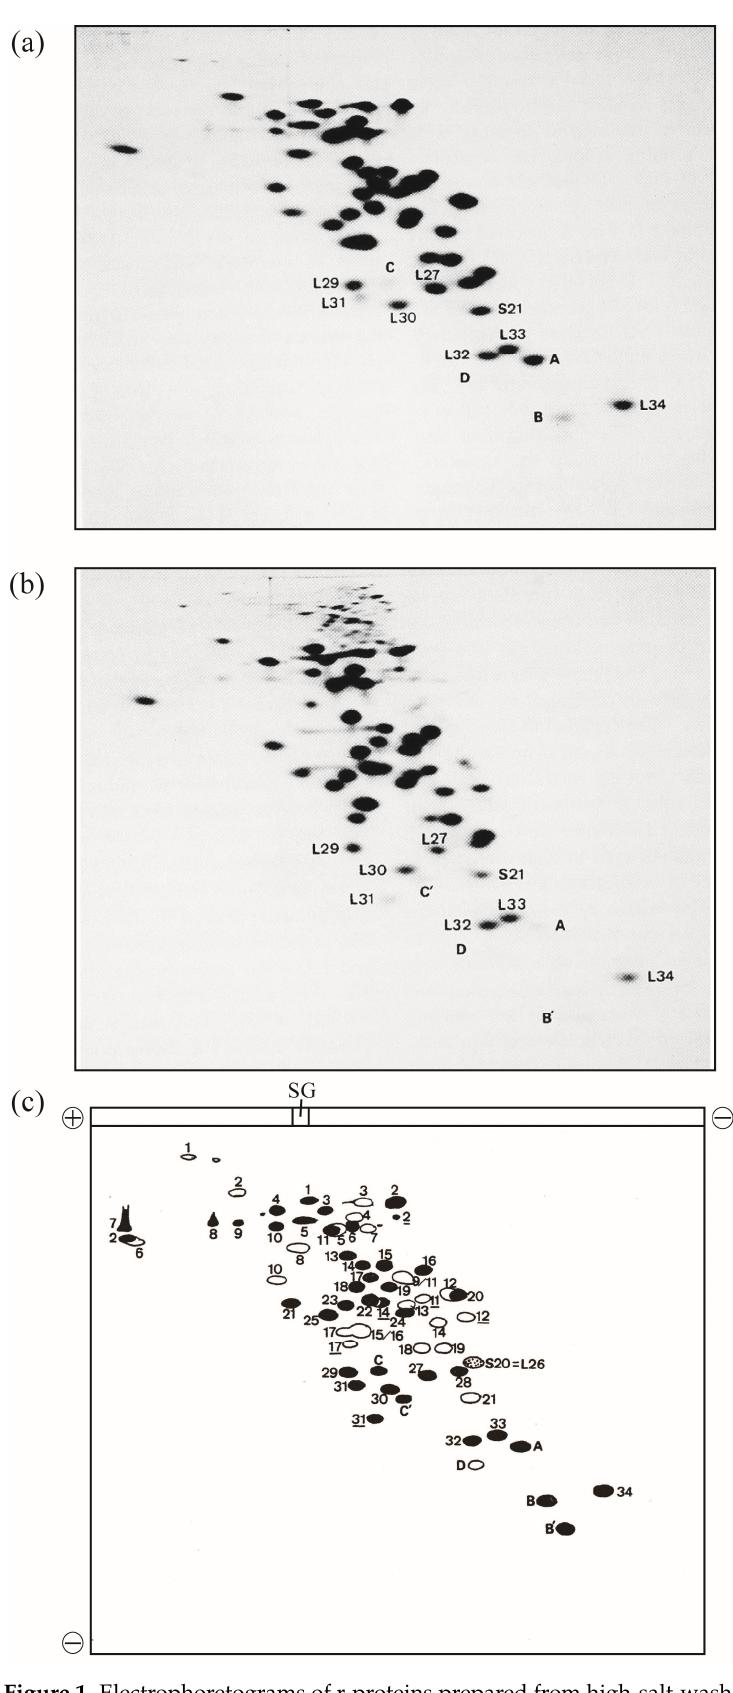
Figure 1. Electrophoretograms of r-proteins prepared from high-salt-washed 70S ribosomes of the E. coli strain Q13. E. coli r-proteins were prepared using the previously described acetic acid method